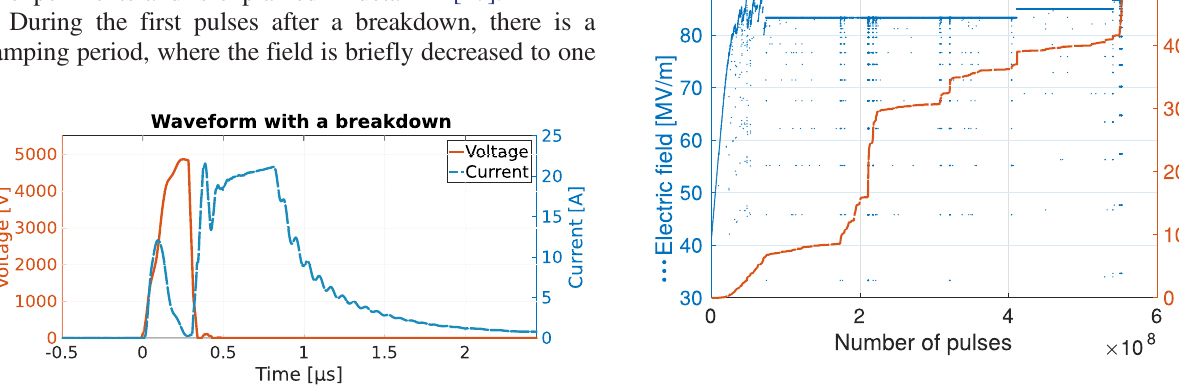
FIG. 3. A typical waveform of a pulse with a breakdown, showing the extra current peak followed by roughly 600 ns of burning voltage. During the breakdown, the voltage drop occurs within approximately five nanoseconds.